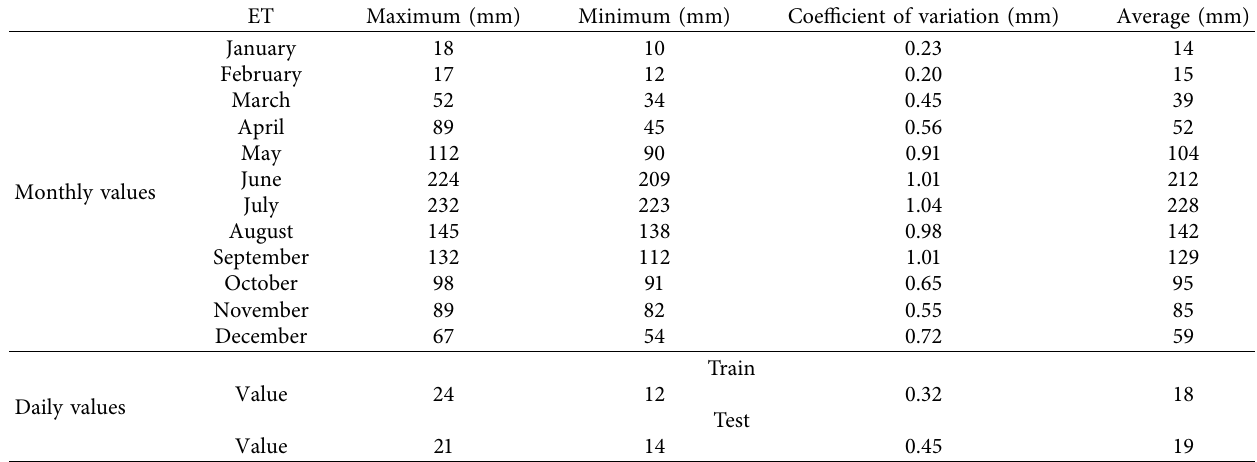
Table 1: Statistical characteristics for ET: monthly and daily